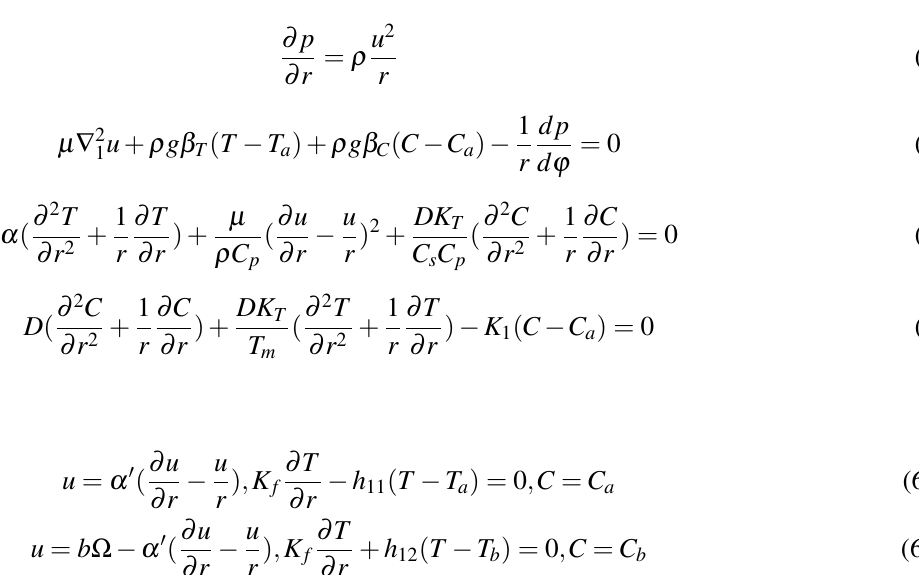
Fig. 1 Flow model and coordinate